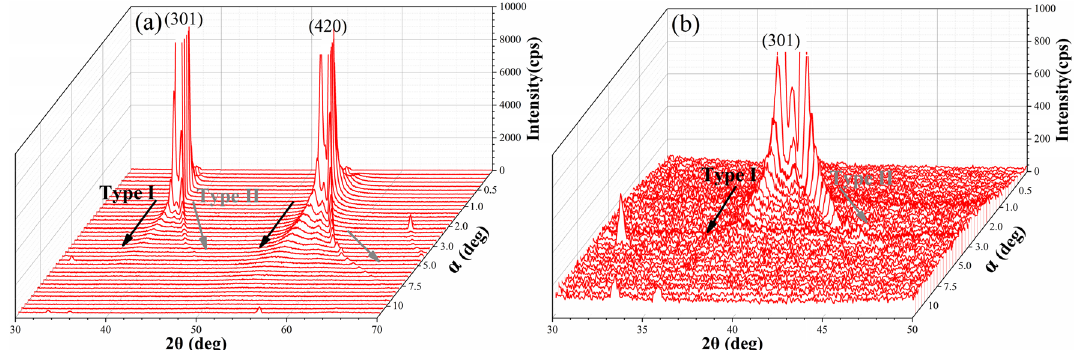
Figure 15. The GIXRD patterns of (010) SPDT surface of bulk single-crystal KDP with increasing incident angle from 0° to 17°: ( a ) the low magnified image and ( b ) the high magnified